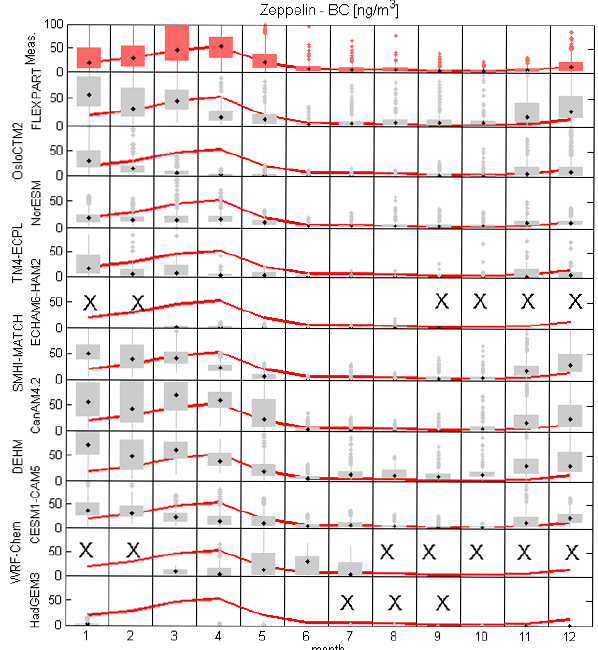
Figure 4. Observed and simulated mean annual cycle of (equiv- alent) BC mass concentrations (ngm − 3 ) at the Zeppelin station. Shown are the monthly frequency distributions using data from the years 2008 and 2009. The uppermost panel (red boxes) shows monthly frequency distributions of the observed eBC concentra- tions. The other panels below (grey boxes) show monthly frequency distributions of the modeled BC concentrations. Black dots depict the monthly median value, the grey boxes span the range between the 25th and 75th percentiles, and red and grey dots represent values that are outside the 1.5 fold of this interquartile range (grey lines). The red line connects the monthly medians of the observed eBC concentrations in the uppermost panel and is repeated in all other panels for the convenience of comparing modeled and measured values. Missing model data are denoted with “X”. Notice that some models have very low BC mass concentrations, which are difficult to see on the scale